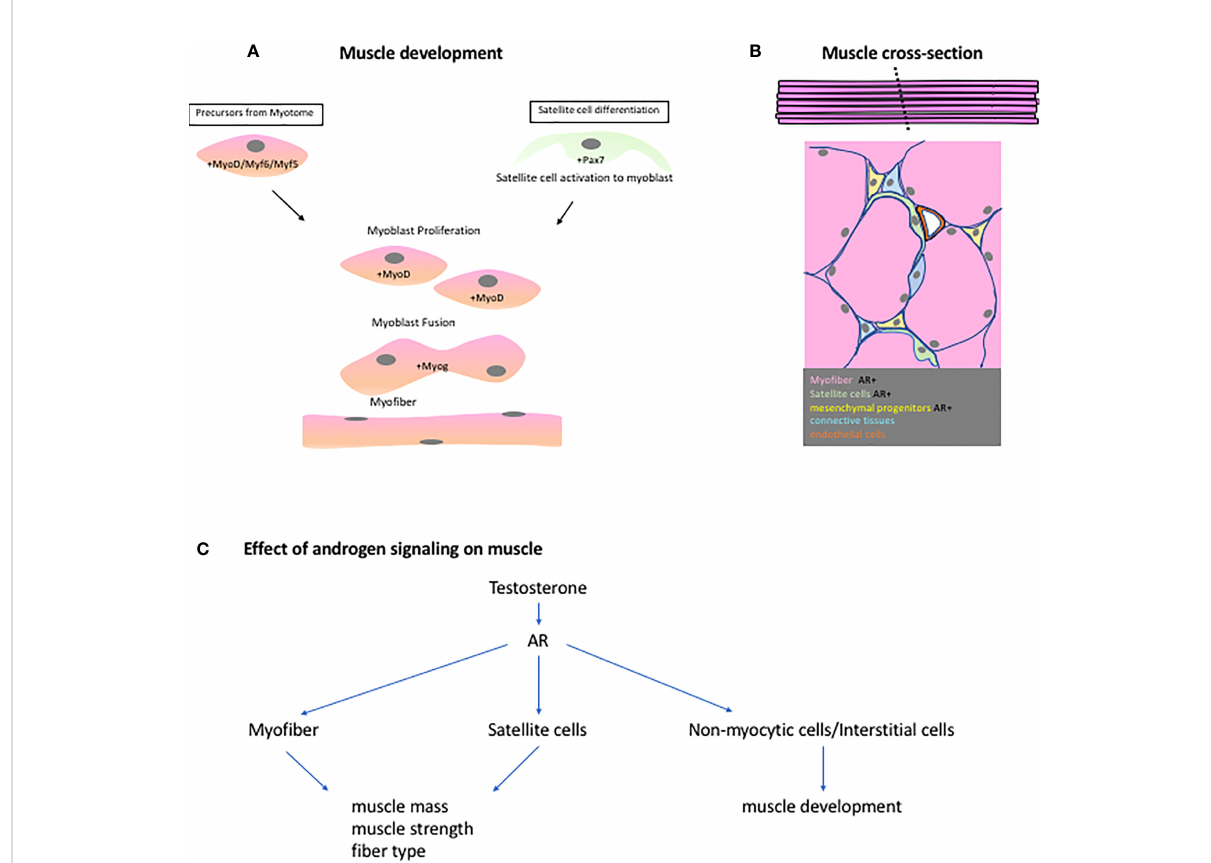
FIGURE 2 (A) Muscle embryonic development is highly regulated by the MRFs (Myf5, Myf6,MyoD and Myog). Precusor myoblast from the myotome travel to different parts of the body to establish the different muscle groups. These precursors or myoblast, expressing MyoD, will proliferate, fuse, and differentiate to form syncytial myo fi bers. During regeneration, the resident stem cells of the muscles, satellite cells, are activated and begin to express MyoD. It will then follow the same steps as in the embryonic muscle development. (B) A cross-section of the muscle shows the different cell population found in the muscles. Some of these cells express AR and are instrumental to the androgen-responsive nature of some muscle groups. (C) A scheme showing the effects of androgen signaling based on ArKO studies on different muscle